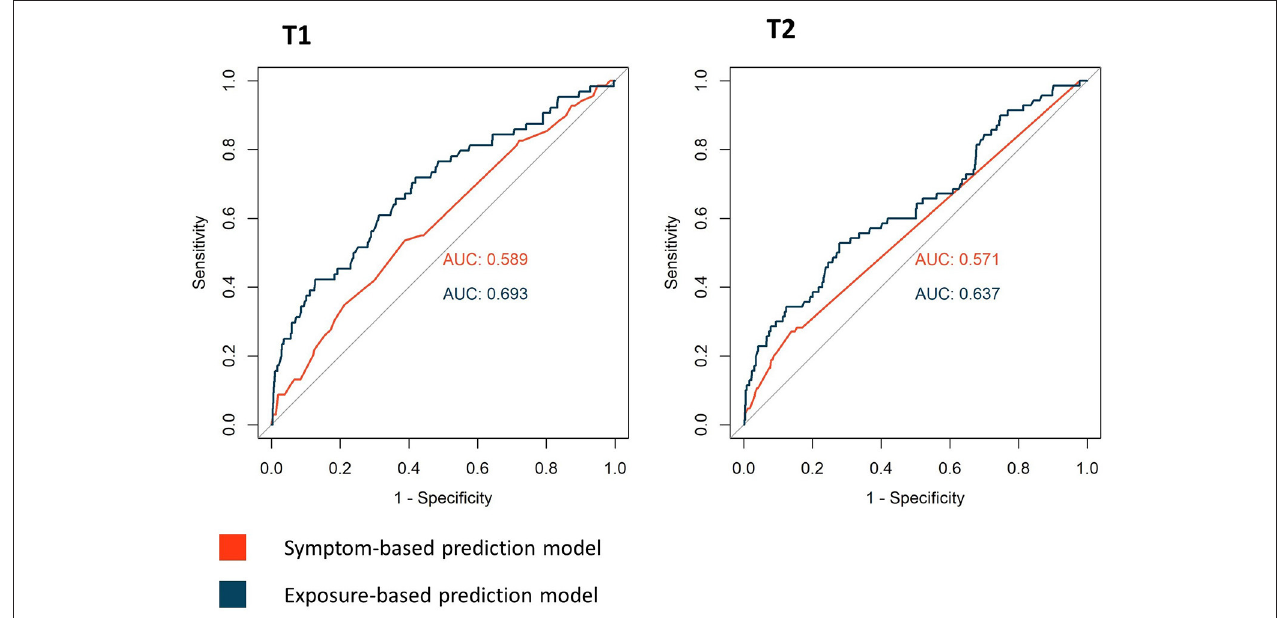
FIGURE 4 | Receiver operating characteristics (ROC) curves for the symptom- and exposure-based prediction models for T1 and T2.